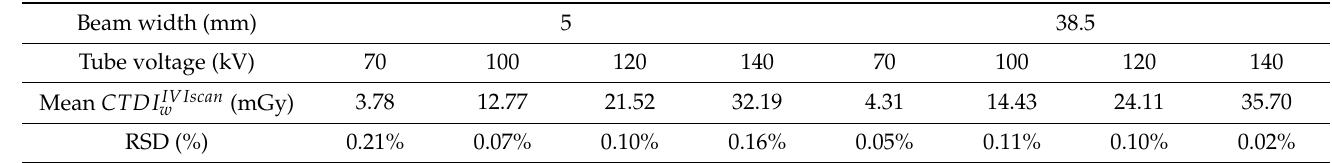
Table 1. Mean CTDI w measured with IVIscan, CTDI IVIscan w , and relative standard deviation (RSD) associated for three replicates on SN1 for head protocols at 70, 100, 120 and 140 kV and for beam widths of 5 mm and 38.5 mm.